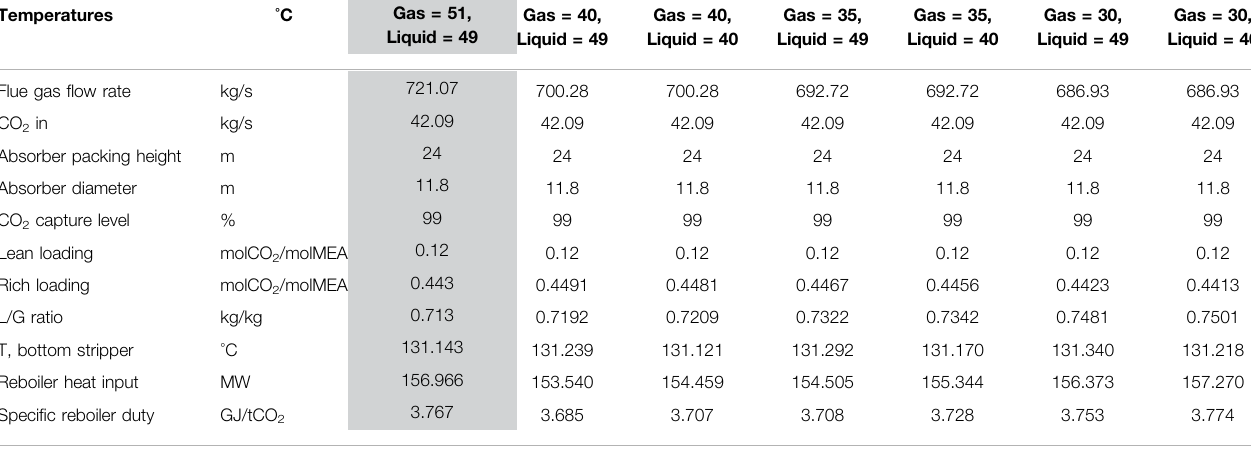
TABLE 4 | Resultsforreducedinlet-to-the-absorbertemperaturesfor99%CO 2 captureandleanloadingof0.12molCO 2 /molMEA(theshadedcolumnreferstothebasecase). Temperatures